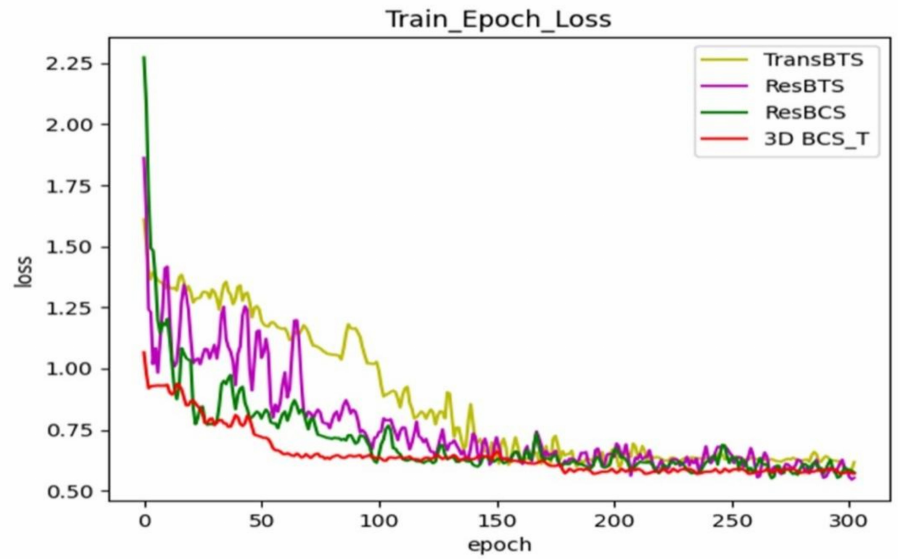
Figure 4. Comparison of the training loss functions with the different modules added to the Trans- BTS network.